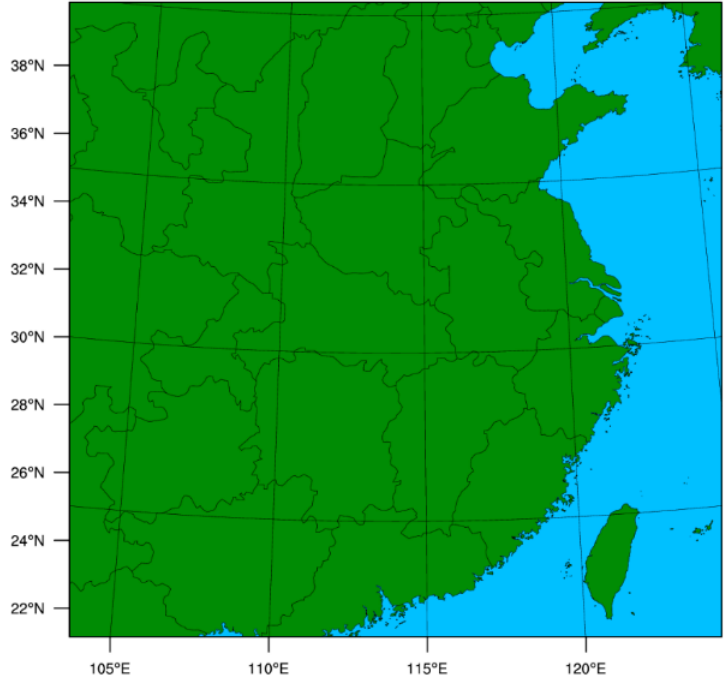
Figure 2. The experimental domain.